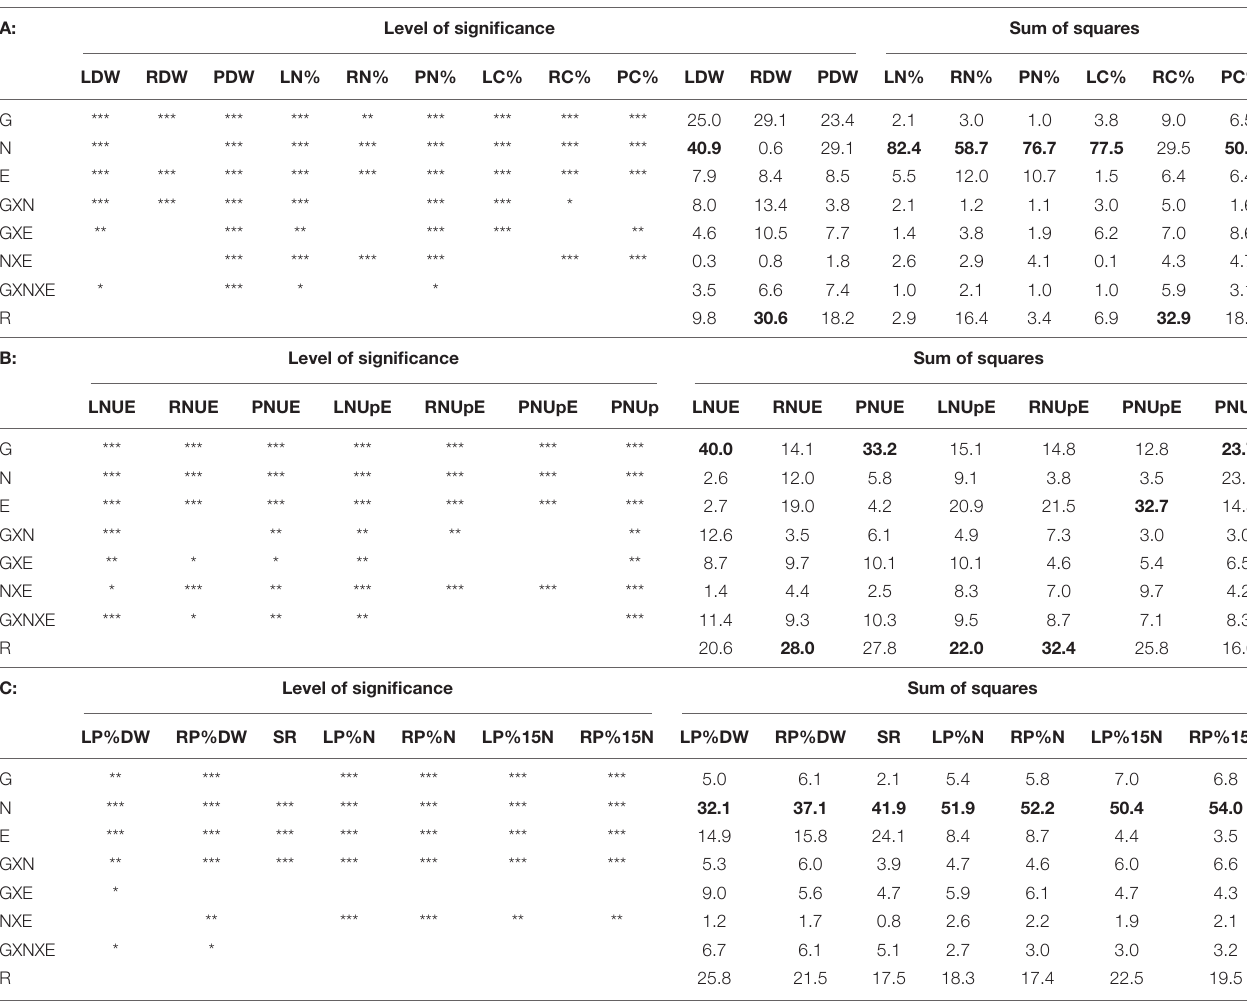
TABLE 3 | Level of significance of the variance sources for biomass and C and N concentrations in barley cultivated under limiting or ample